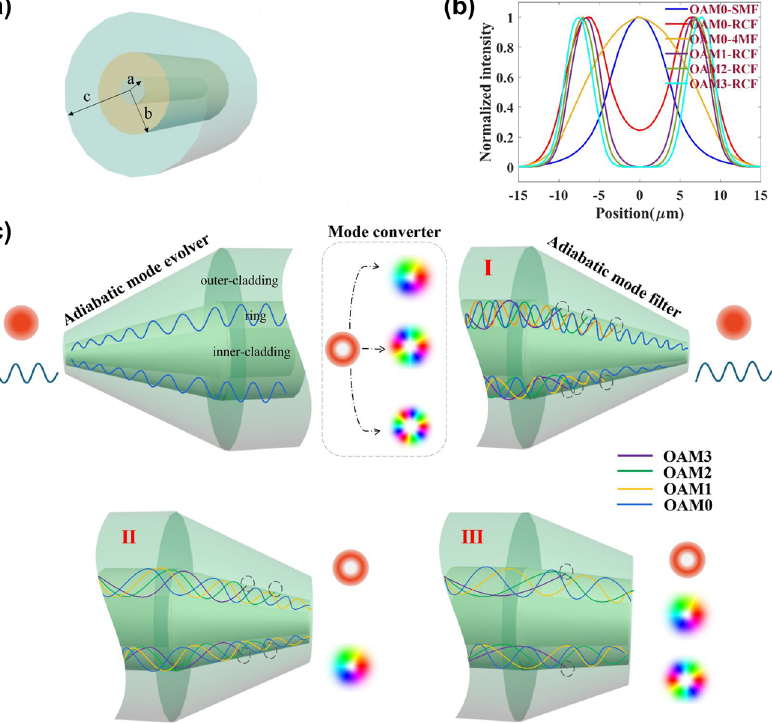
Figure 1: The schematic diagram. (a) Schematic of the ring-core fiber. (b) The normalized intensity profile of the fundamental mode in SMF, 4 MF and each order mode in RCF. (c) Schematic of